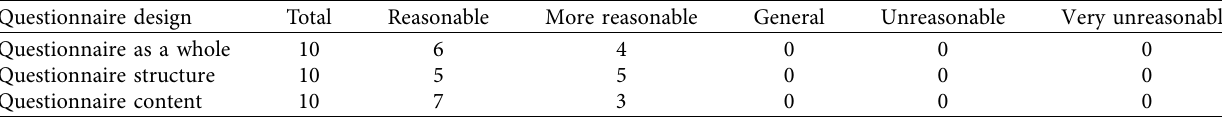
Table 1: Expert inspection of questionnaire